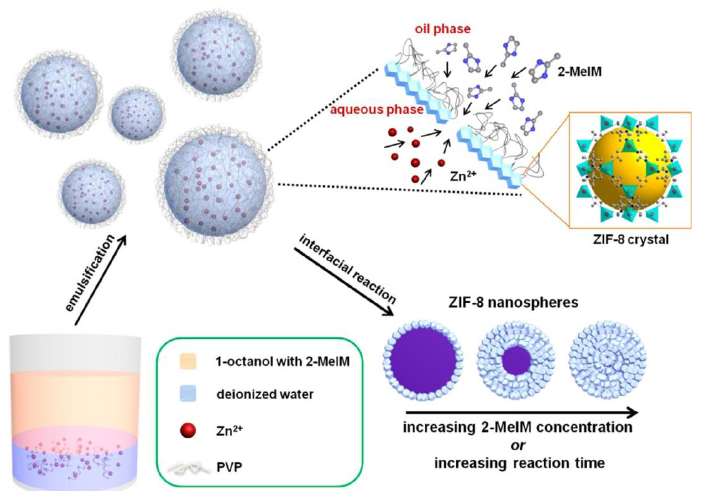
Figure 8. Schematic diagram for the synthesis of a hollow ZIF-8. Reprinted with permission from Ref. [55]. Copyright 2014, American Chemical Society.